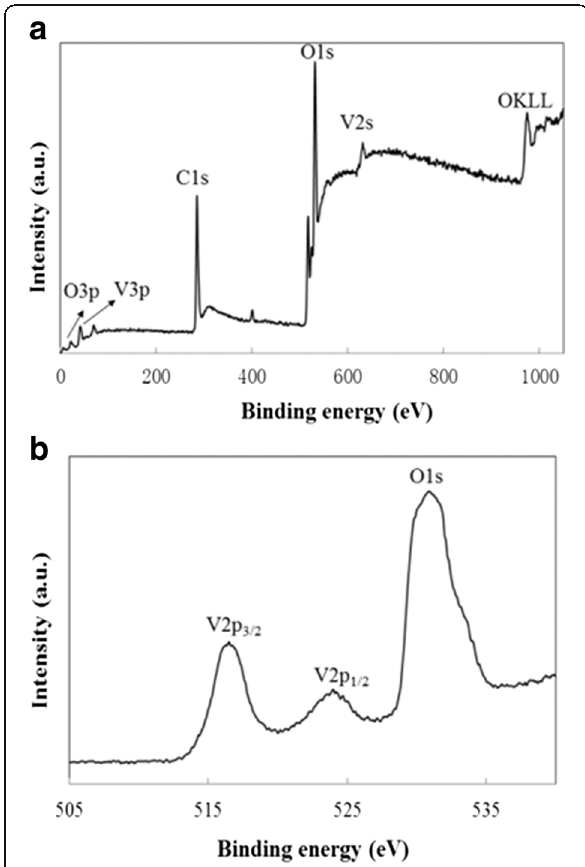
Fig. 3 XPS spectra: survey scan. a V 2p and b O of 2D VO 2 microarrays